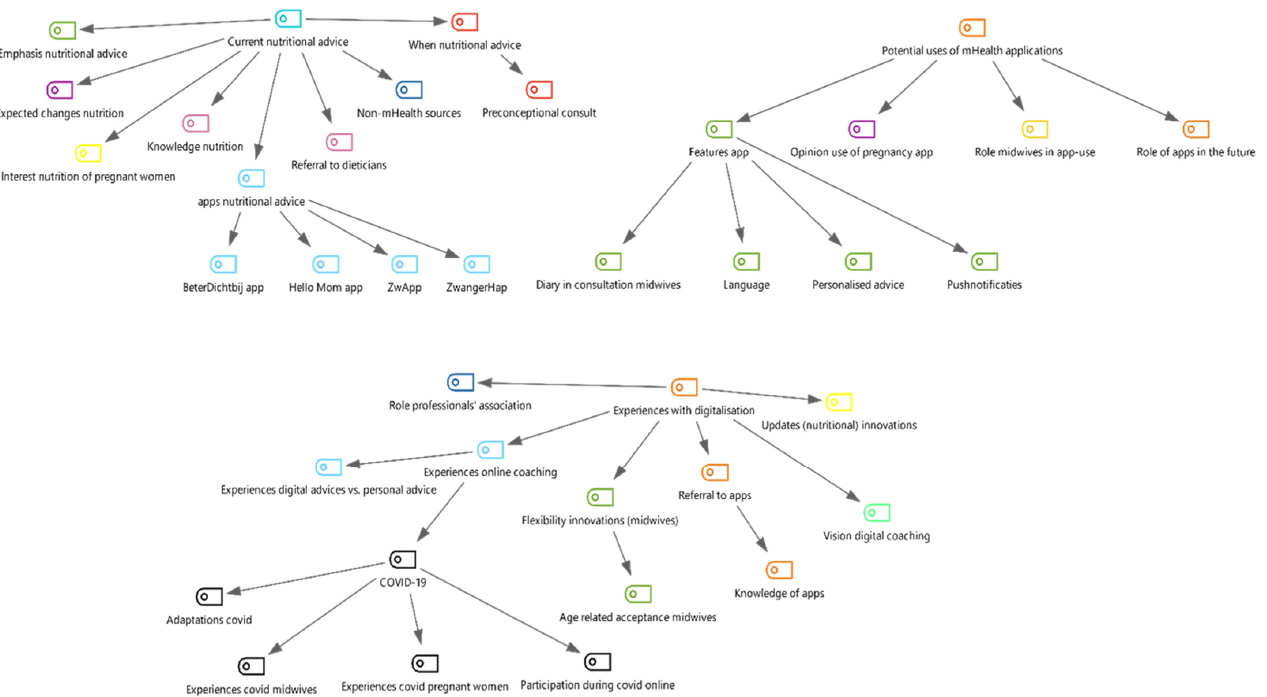
Figure A 1. Code tree. Figure A1. Code